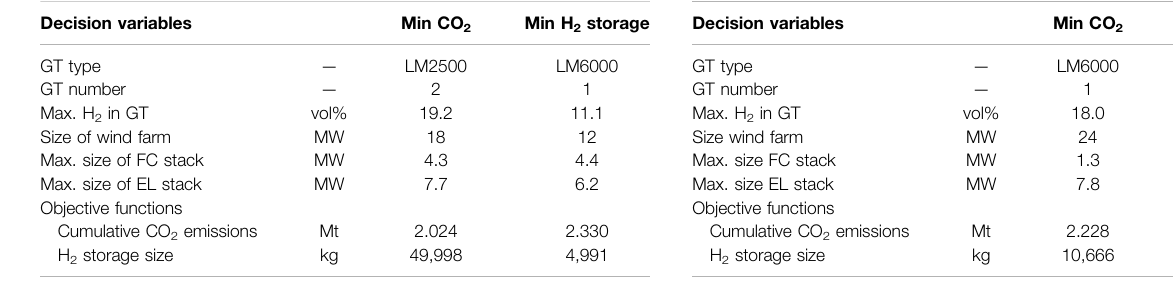
TABLE 6 | Optimal designs of the alternative wind data case - Pareto 2. TABLE 7 | Optimal designs accounting for grid dynamics - Pareto